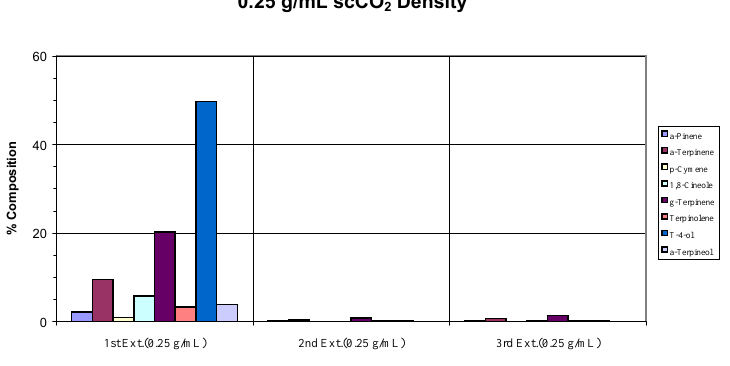
Figure 3. Recovery of target analytes from whole dried leaves using a chamber temperature of 110 o C. (3) Rehydrated Whole Dried Leaves